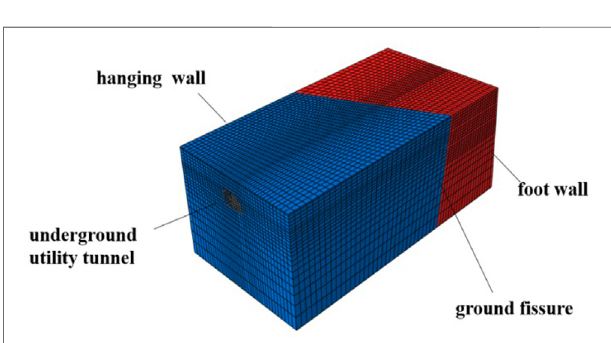
FIGURE 2 | Schematic of FE numerical calculation